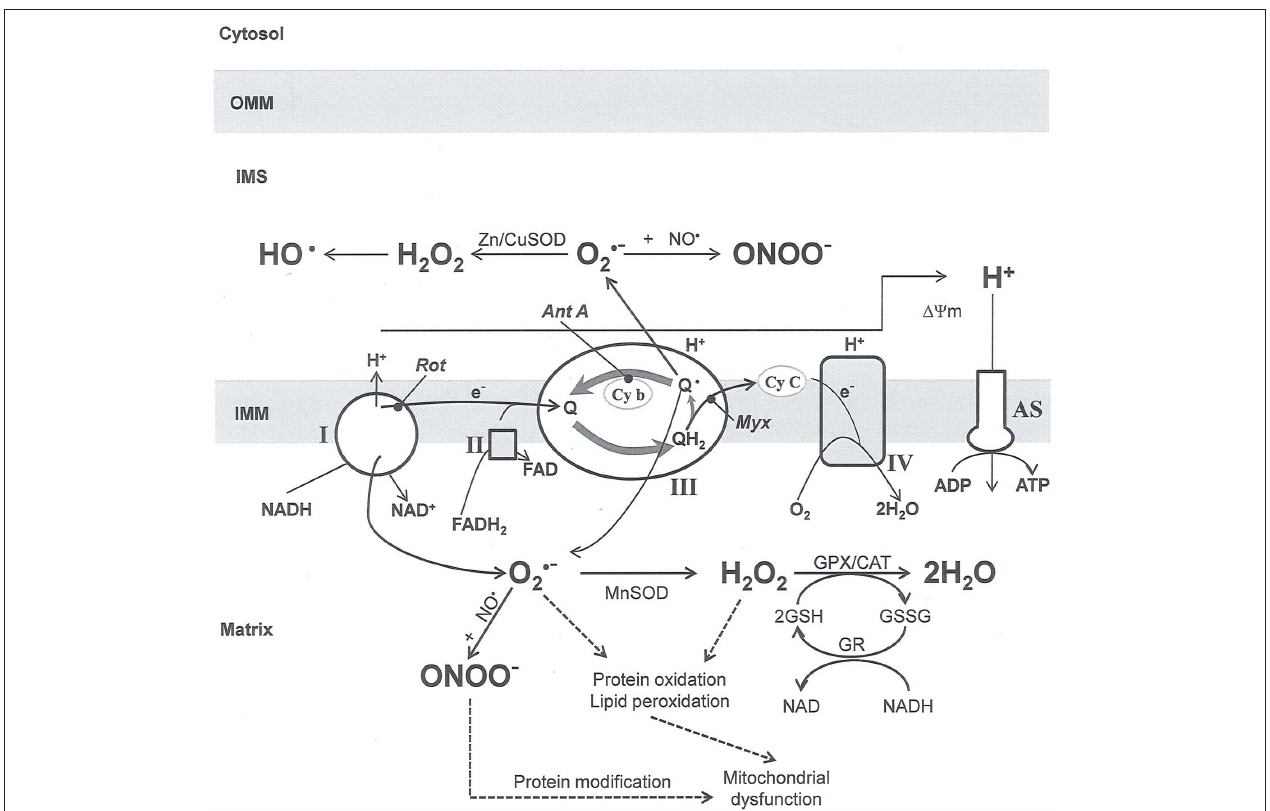
Figure 4 | Principal mechanisms for mitochondrial reactive oxygen species (rOS) generation. Reduced substrates synthesized in metabolic pathways supply e − to complex I and complex II of the ETC. The major centers for superoxide